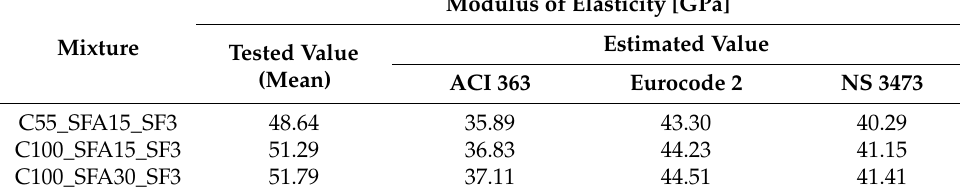
Table 7. Comparison between modulus of elasticity values obtained from tests (according to EN 12390-13) and those estimated by three different models: ACI 363 [30], EN 1992-1-1 [26] and NS 3473 [31]. values would be 51.90 GPa (C55_SFA15_SF3), 53.04 GPa (C100_SFA15_SF3) and 53.41